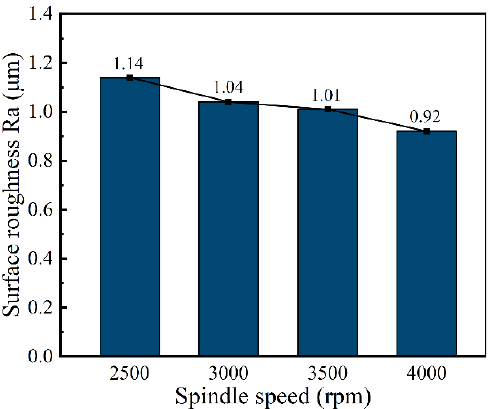
Figure 14. The surface roughness (Ra) of sidewall with different spindle speeds.